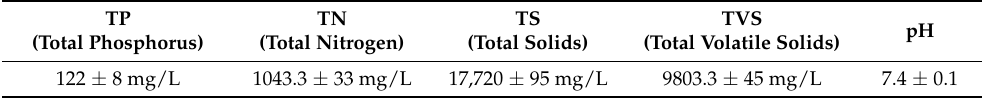
Table 1. Anaerobically digested sludge characteristics.